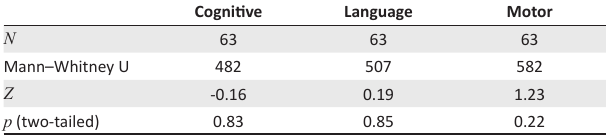
TABLE 3: Test statistics for the comparison of the intervention ( N = 29) and control groups ( N = 34) for each subscale before the intervention. Cognitive